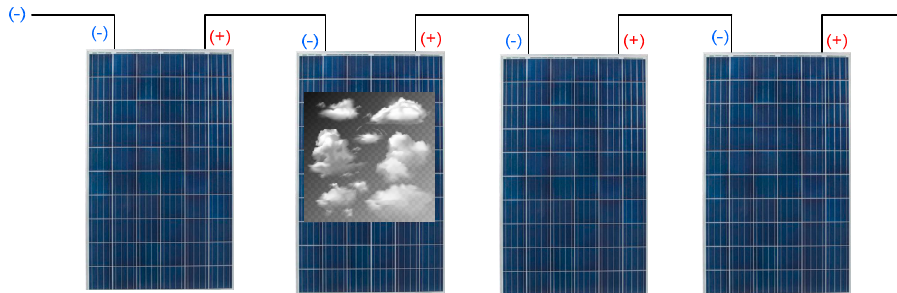
Figure 7. Partial shading in photovoltaic panels.